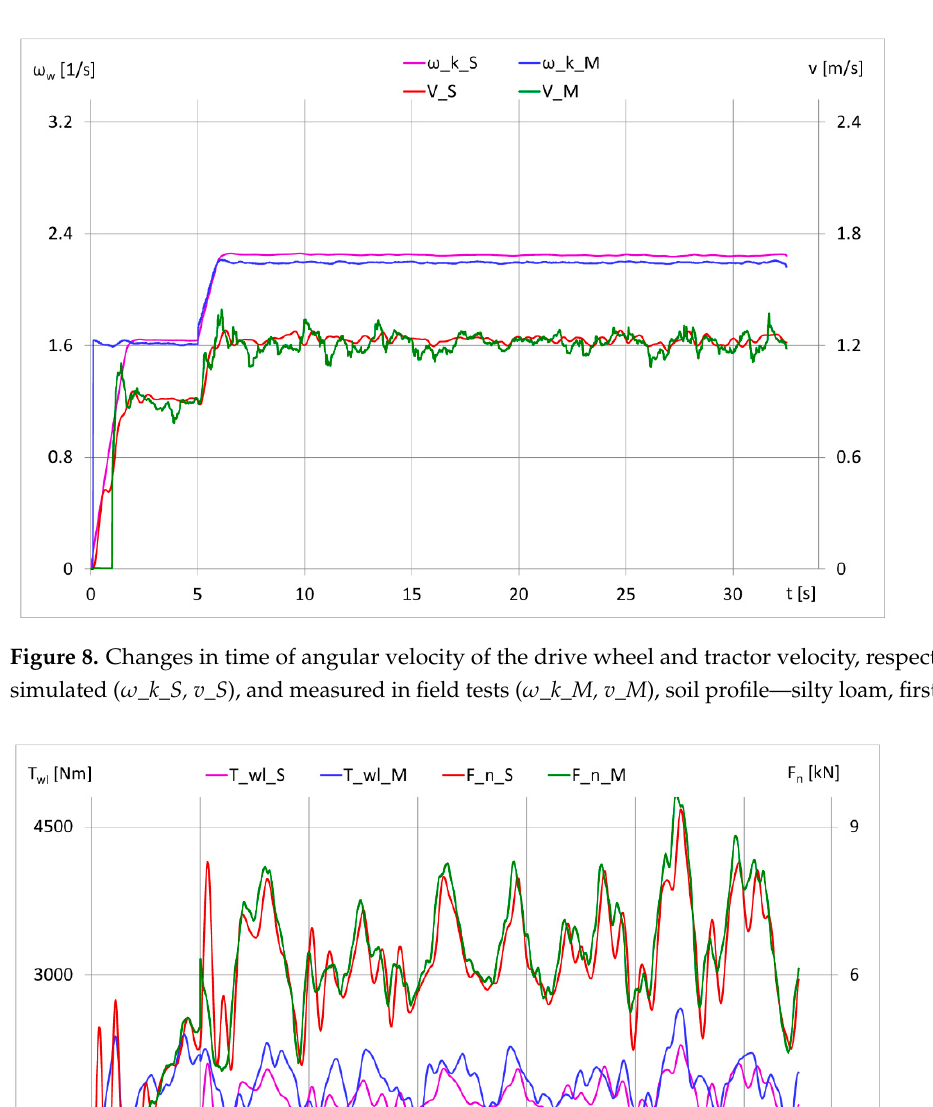
Figure 7. Changes in time of the measured drawbar pull of the tractor F d with enabled force con- trol system; soil profile—silty loam, first gear. The values selected for the validation of the model included the angular velocity of the drive wheel ω w , linear velocity of the unit V p as presented in Figure 8, torque of the drive wheel axle shaft T w , and driving force of the tractor F n as presented in Figure 9. Measurement values are marked with the letter M , while those obtained from simulation tests are marked with the letter S .